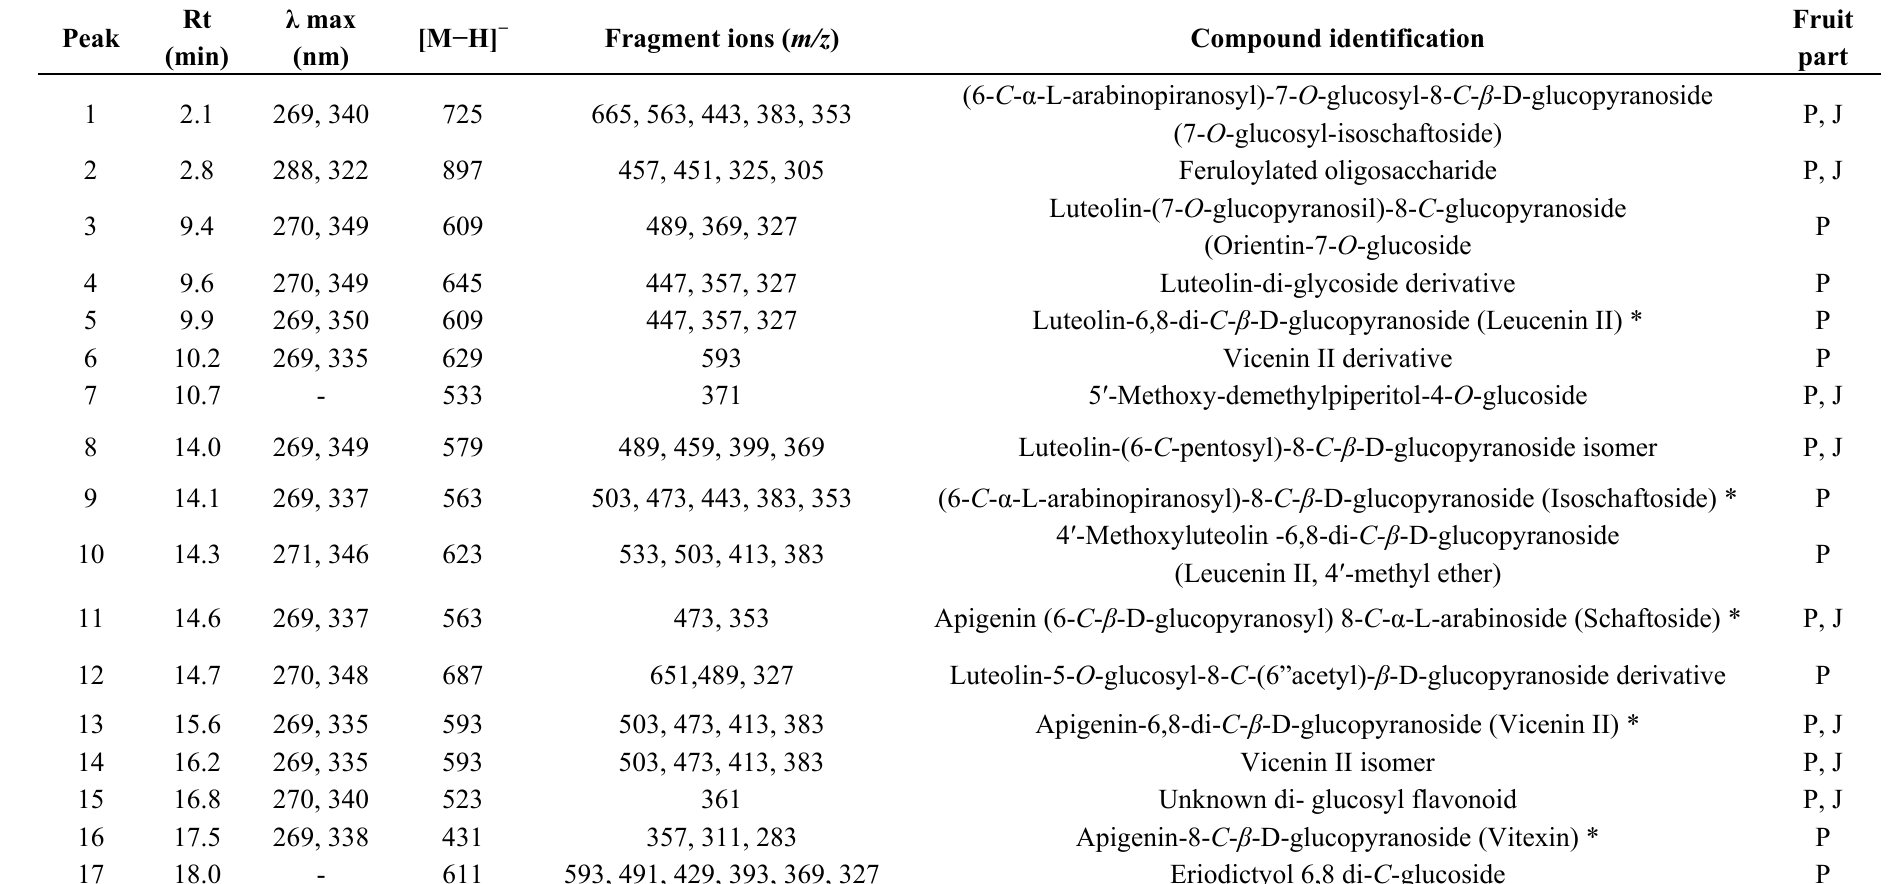
Table 2. Identification of phenolic compounds in tumbo fruits by LC-DAD, LC–MS and MS/MS data. Peak Compound identification